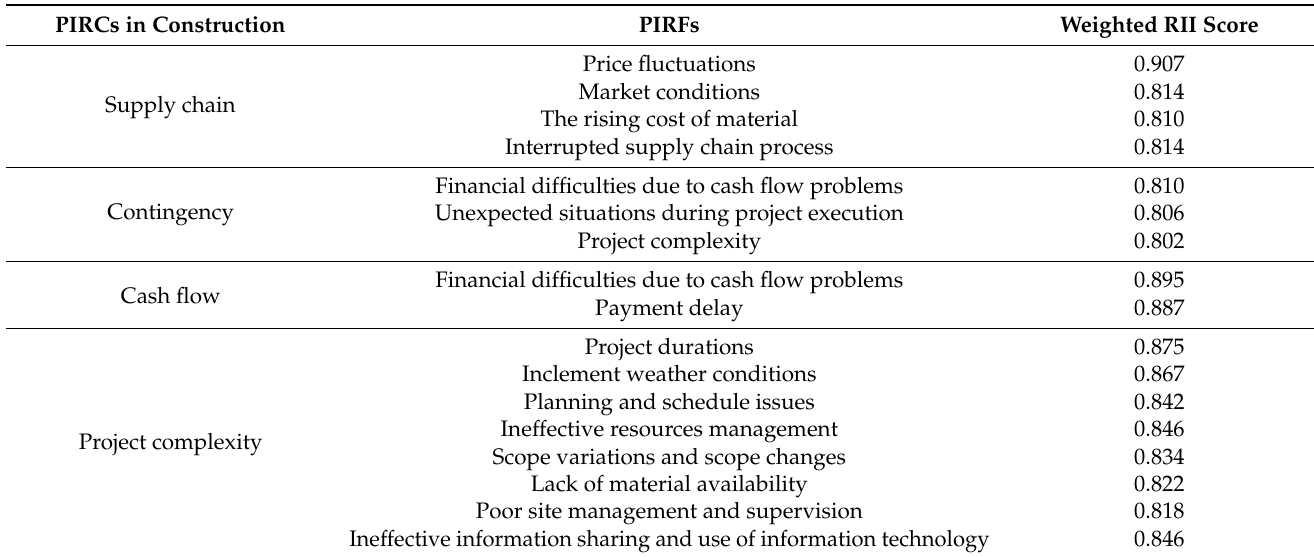
Table 4. Scrutiny of immediate PIRFs based on